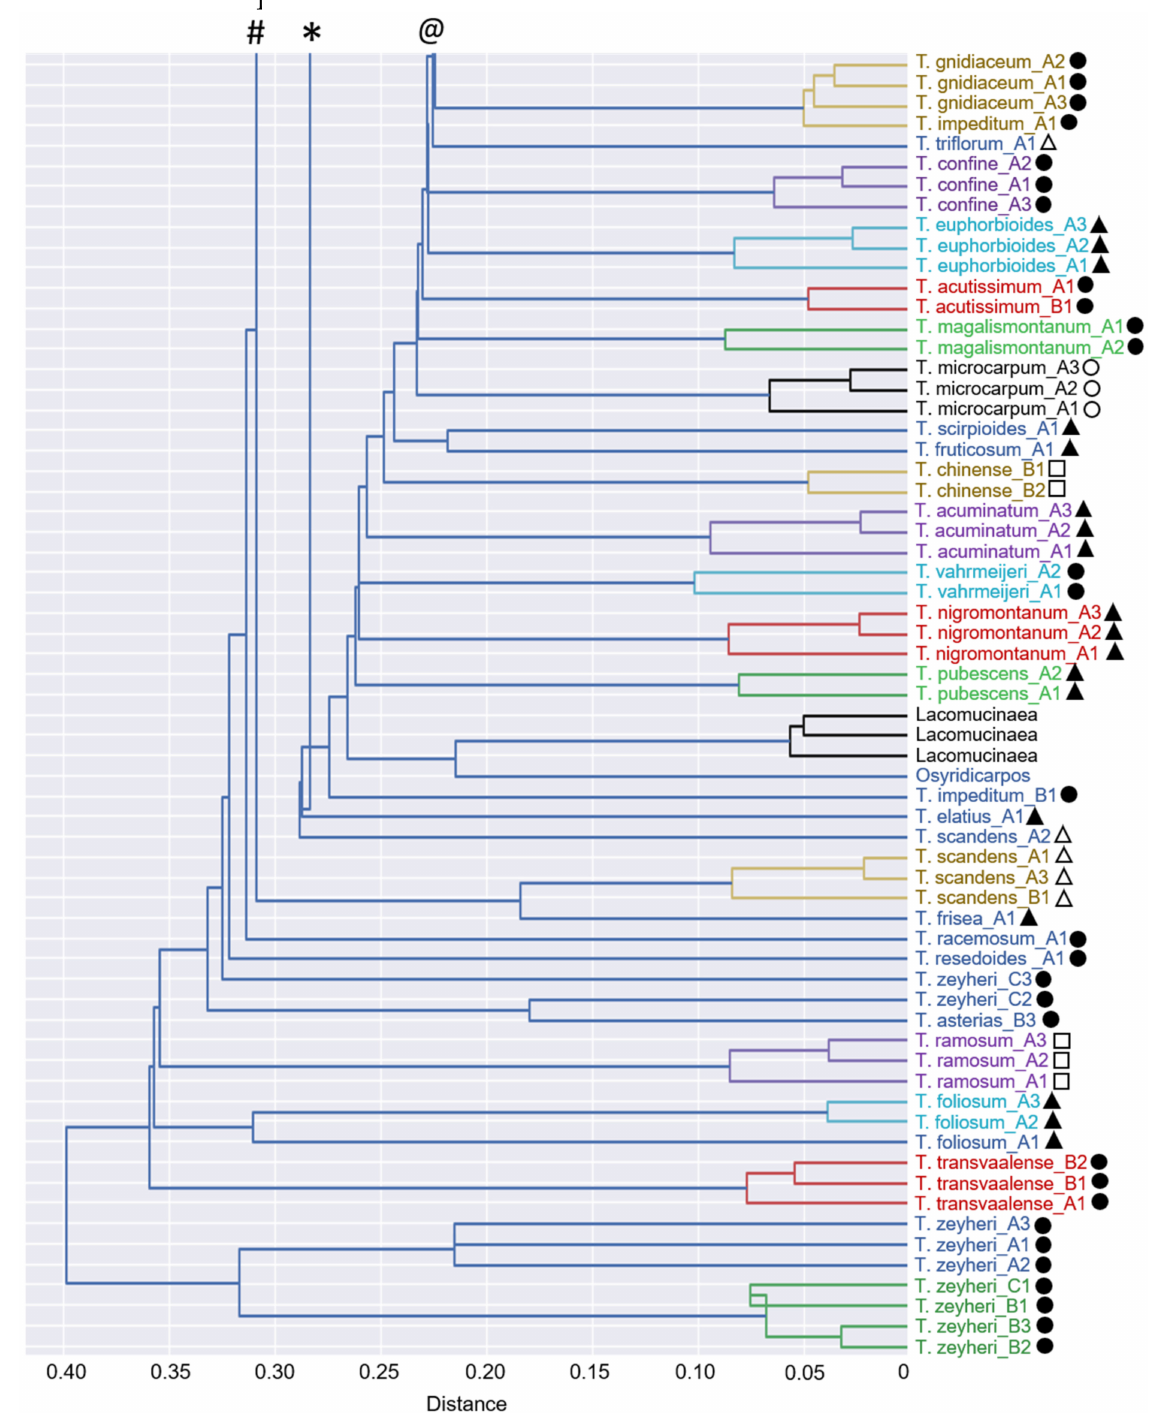
Figure 2. Dendrogram with clusters showing the relationships among 46 Thesium species, Laco- mucinaea lineata and Osyridicarpos schimperianus , based on phenolic compound composition. The placements of subgenera are also shown: Discothesium (clear triangles), Frisea (solid triangles), Hag- nothesium (clear circles), Psilothesium (solid circles) and Thesium (clear squares). Clusters are shown in different colours. Species names corresponding to sample labels are provided in Table